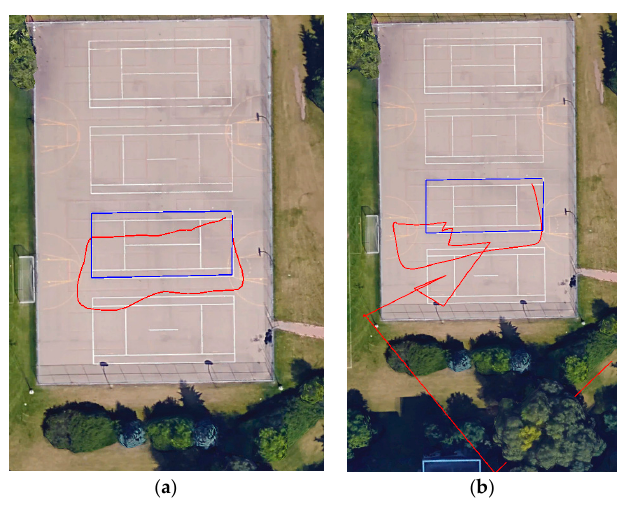
Figure 1. ( a ) First test; ( b ) Second test @ Google. Table 1. Example of iPhone 6 chipsets accuracy over known distance.